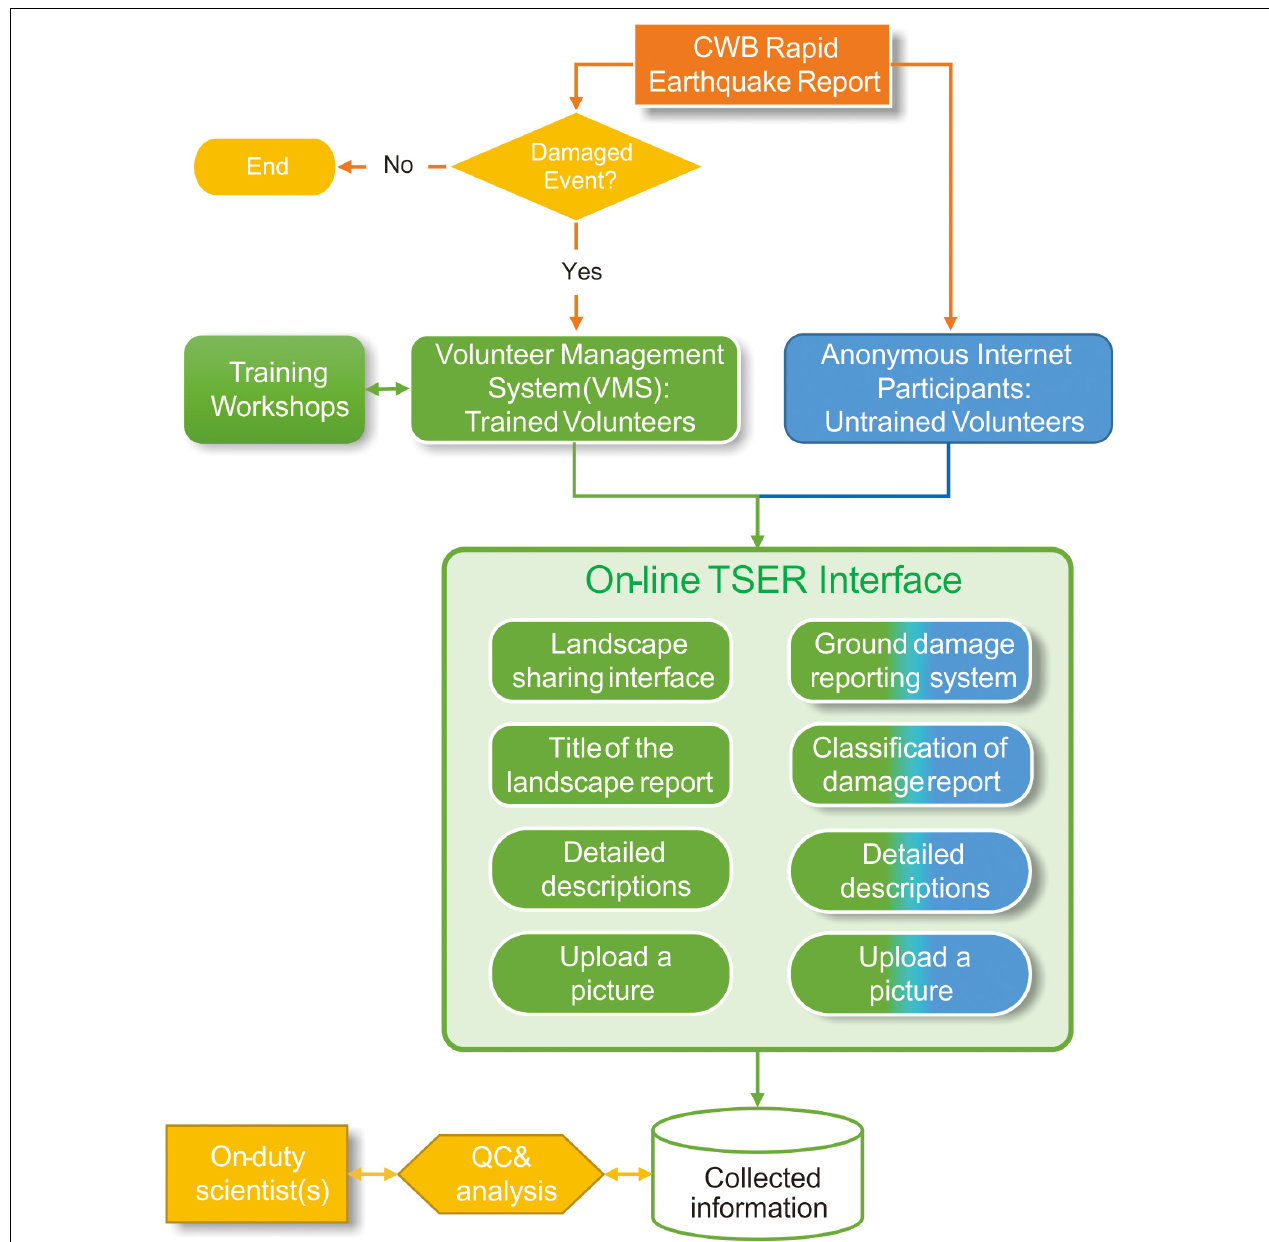
FIGURE 2 | A workflow diagram illustrating the rationale of the Taiwan earthquake scientific reporting (TSER) system. Yellow boxes indicate those actions taken by scientists involved in this project. Green boxes show three major components (see main text) developed in this project. Blue boxes represent the way that untrained volunteers may contribute to this